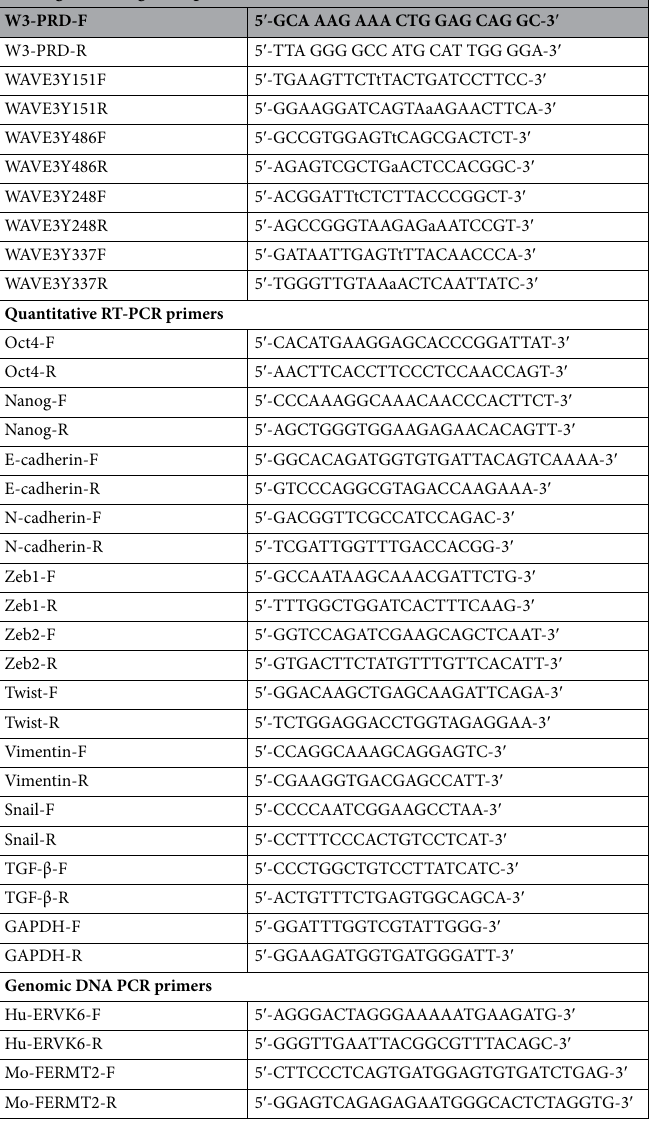
Table 1. List of primers and their sequences used in this